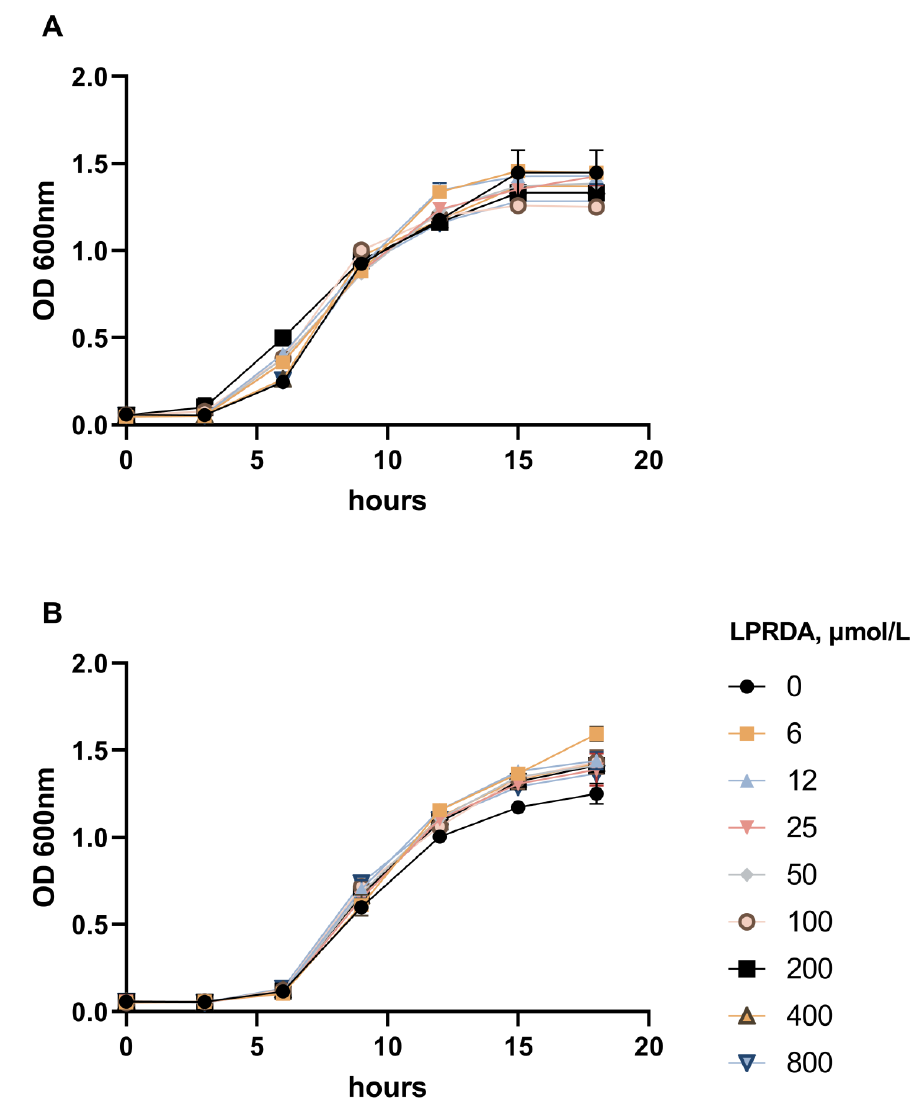
Figure 1. The growth curves of S. aureus ATCC 29213 (MSSA) ( A ) and S. aureus ATCC 43300 (MRSA) ( B ) biomass with various concentrations of the oligopeptide LPRDA. Table 1. Adhesion parameters of S. aureus strains modified by LPRDA to Vero